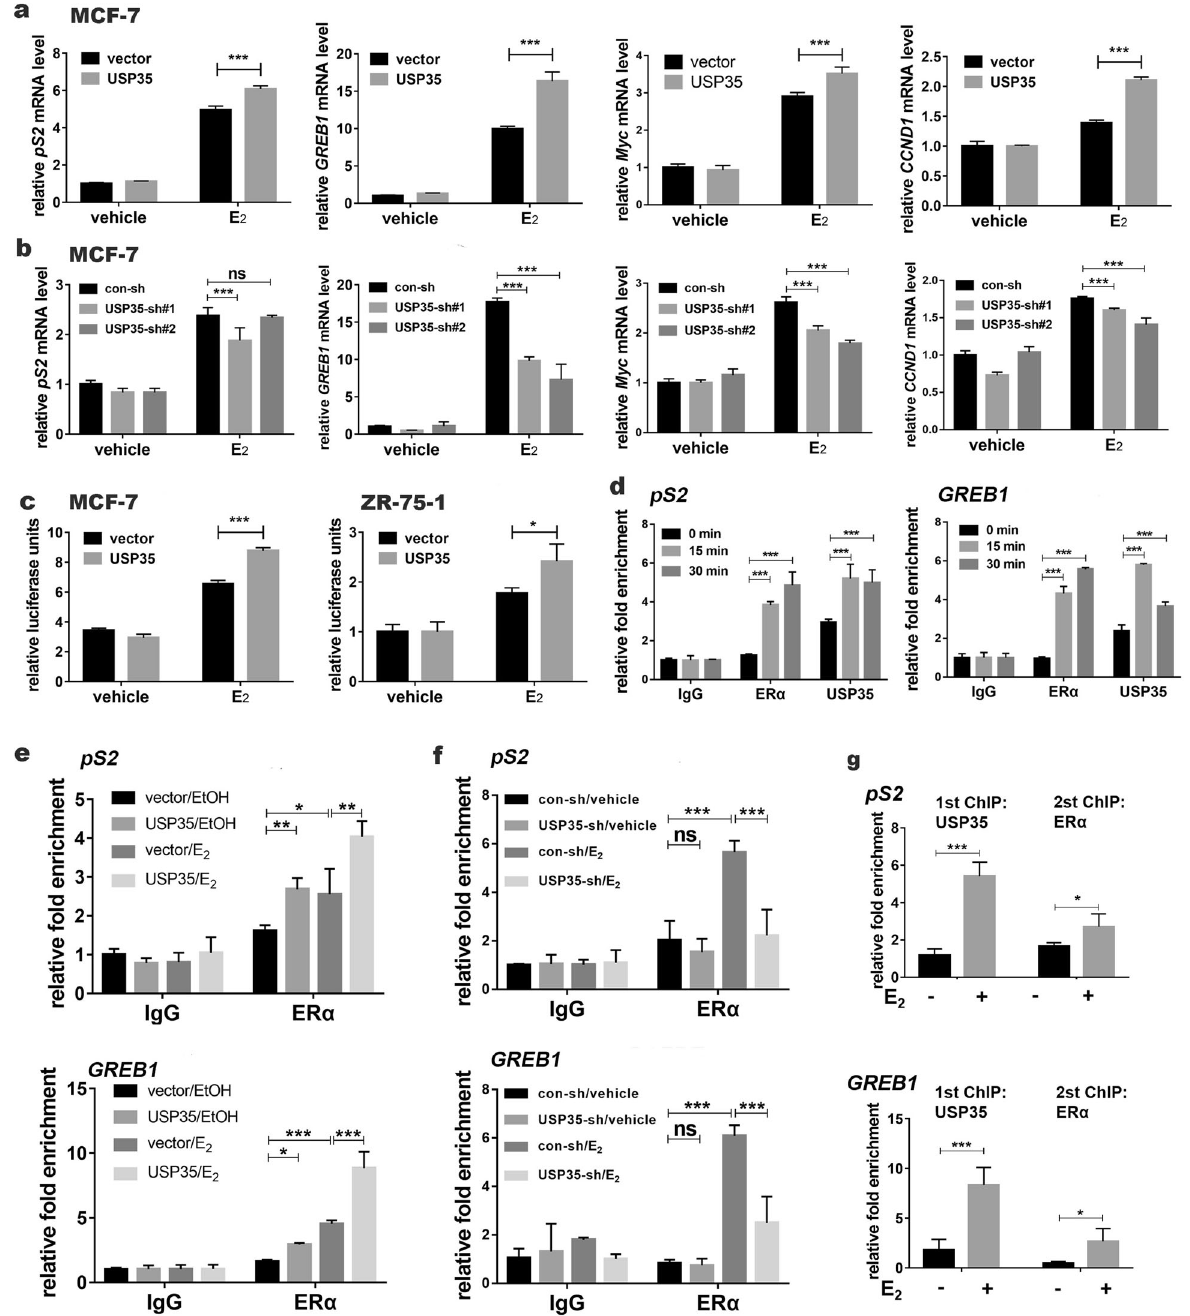
Fig. 5 USP35 enhances ER α transcriptional activity by binding to estrogen responsive element containing region in ER α target genes. USP35 overexpression increases ( a ) and USP35 knockdown decreases ( b ) mRNA levels of the estrogen induced genes. Indicated MCF-7 cell lines were treated with vehicle or E 2 (10 nM) for 6 h before subjected to qRT-PCR assay. c USP35 overexpression enhances ERE-luciferase reporter activity. Indicated cell lines were cotransfected with C3-ERE-luc reporter and TK-renilla plasmids, treated with E 2 (10 nM) for 24 h, and subjected to luciferase activity assay. TK renilla luciferase was used to normalize transfection ef fi ciency. d Estrogen enhances USP35 binding to ERE-containing region in the ER α target genes. MCF-7 cells stimulated with E 2 (10 nM) were subjected to ChIP assay using USP35 or ER α antibody followed by qPCR of the pS2 and GREB1 DNA regions containing ERE. The quanti fi cation of fold enrichment relative to input levels was shown. e , f USP35 promotes ER α binding to ERE-containing region in pS2 and GREB1 in MCF-7 cells. MCF-7 cells stably expressing vector and USP35 ( e ) or MCF-7 cells expressing con-sh and USP35-sh#1 ( f ) were stimulated with E 2 (10 nM) for 15 min and subjected to ChIP assay using ER α antibody. g USP35 and ER α are recruited together to ERE-containing regions of pS2 and GREB1 . MCF7 cells were ChIP and re-ChIP using USP35 and ER α antibodies sequentially. Chromatin samples were analyzed by qPCR. *, p < 0.05; ***, p < 0.001.